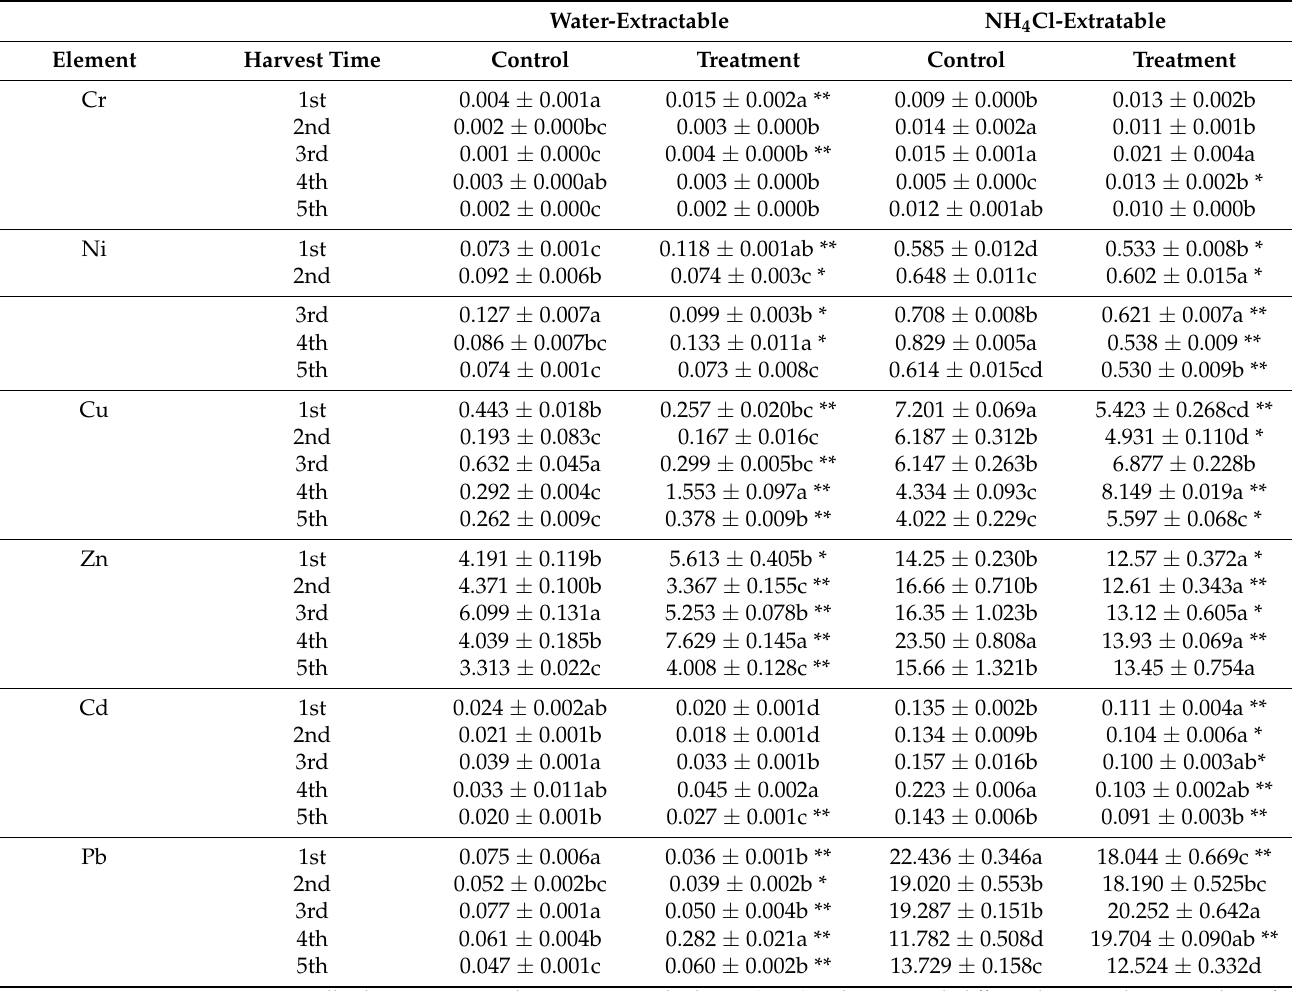
Table 1. Water-extractable and NH 4 Cl-extratable heavy metals in the soil at different harvest times during the period of the greenhouse